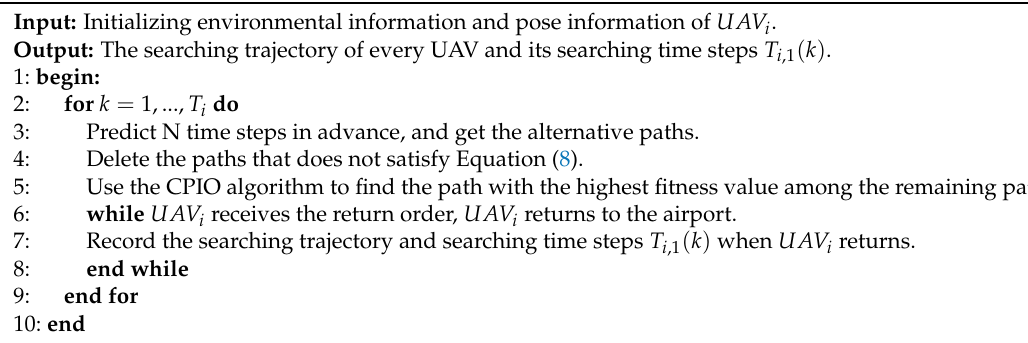
Algorithm 1 MUCS based on CPIO